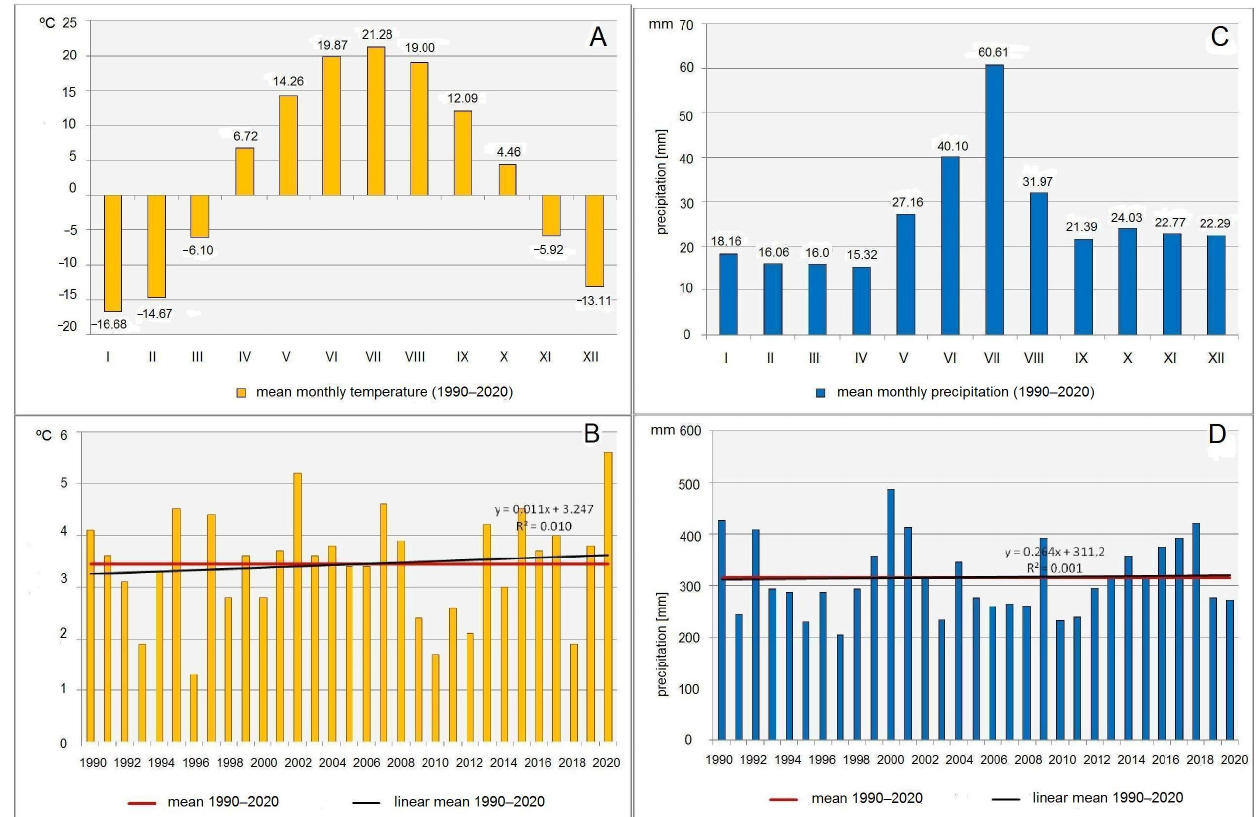
Figure 9. Mean air temperature and precipitation records for NE Kazakhstan for the 1990–2020 period. ( A ) Monthly mean temperature; ( B ) annual mean temperature with a trend-line and regression equation of the MAAT anomalies showing just a slightly rising regional temperature during the last ten years; ( C ) monthly mean precipitation; ( D ) annual precipitation record with a minor long-term precipitation increase over the past decades (analysis of the raw meteorological data; the Pavlodar Meteorological Station).